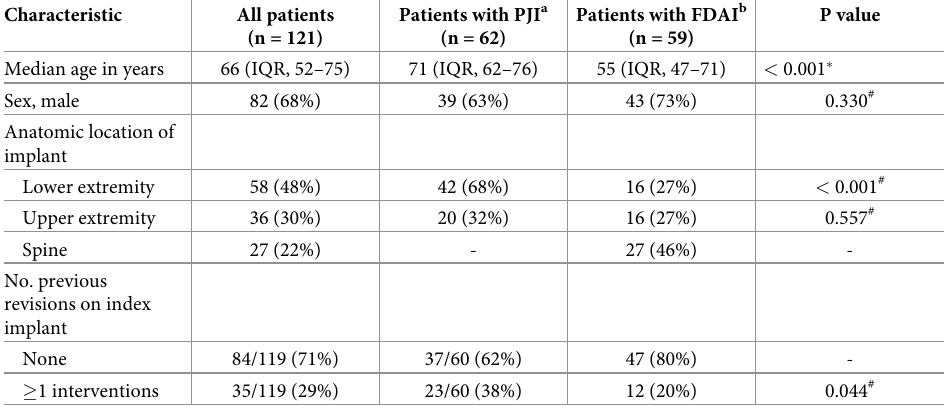
Table 1. Characteristics of 121 patients with orthopedic implant-associated infections, including 62 with peri- prosthetic joint infections (PJI) and 59 with fixation device-associated infection (FDAI). Characteristic All patients (n =